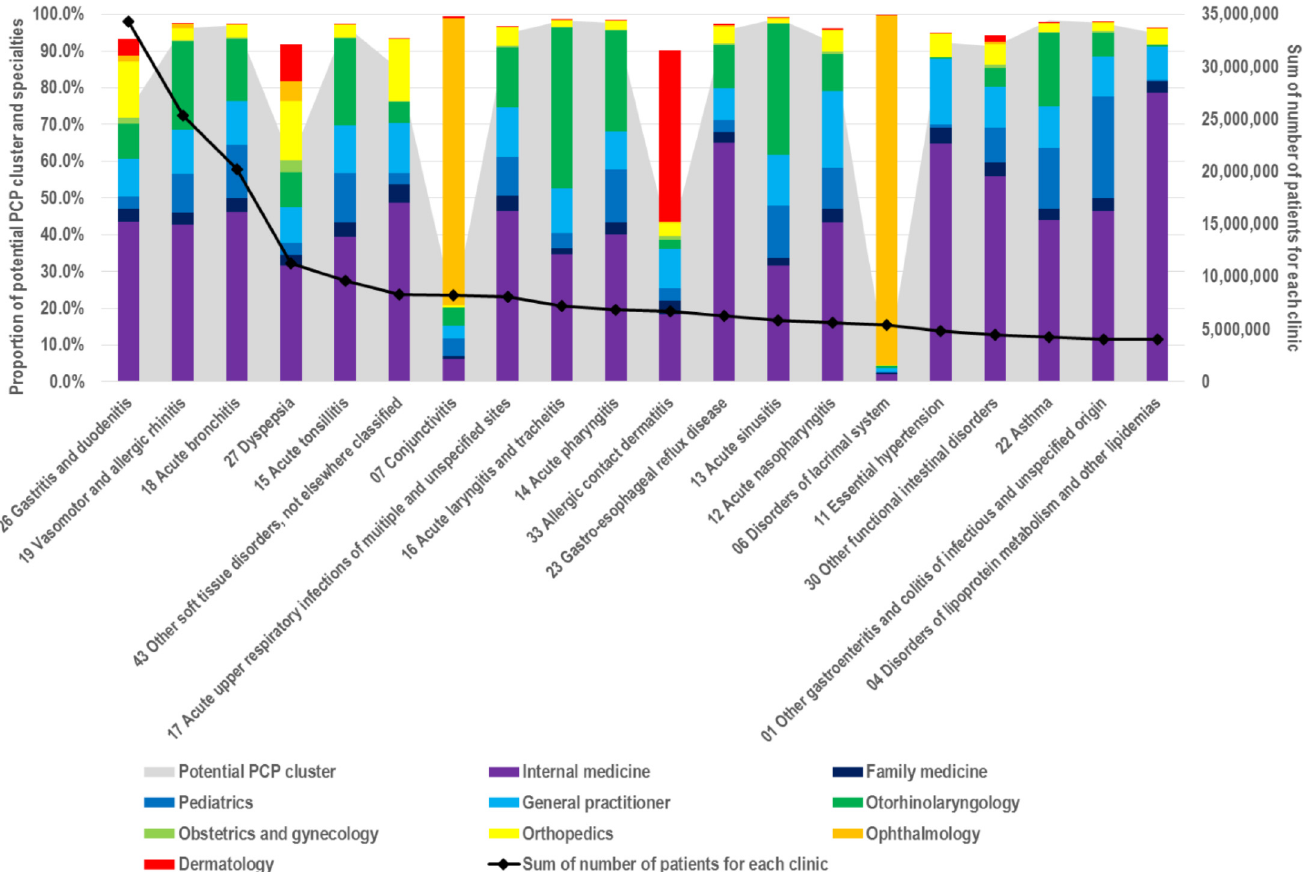
Fig 1. Twenty most common simple or minor disease groups and proportions of potential PCP clusters and specialties. Abbreviations: PCP, primary care provider.